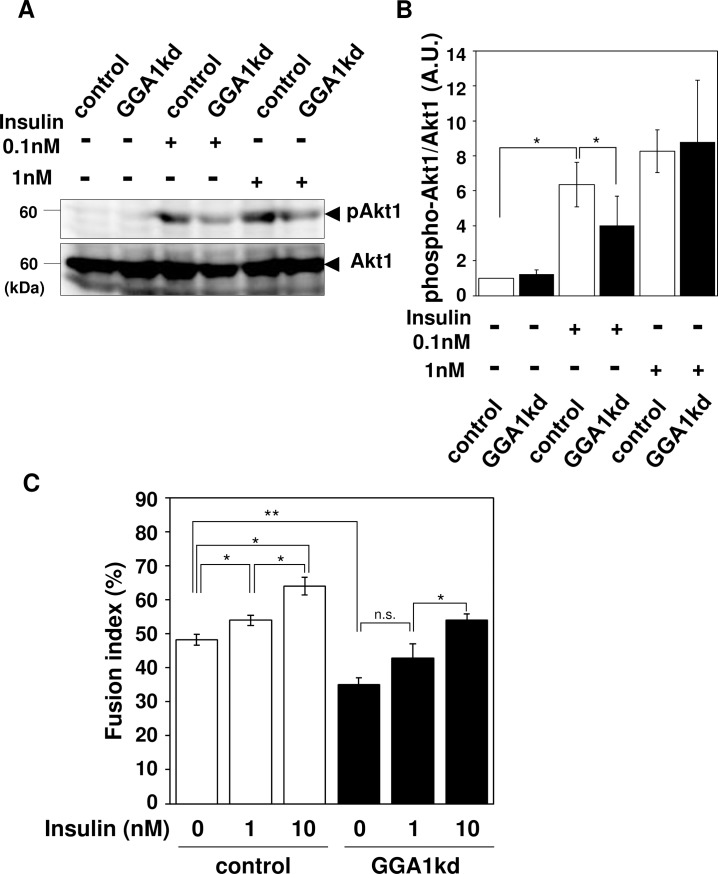
GGA1kd cells exhibit defective insulin response.(A) C2C12 cells treated with control and Gga1 (Golgi associated, gamma adaptin ear containing, ARF binding protein 1) siRNAs were stimulated by 0, 0.1, and 1 nM insulin for 5 min. Insulin signaling was then examined using anti-phospho AKT serine/threonine kinase 1 (AKT1) and anti-pan AKT1-specific antibodies. (B) The quantification of the phospho-AKT1/total AKT1 ratio is indicated on the right bar graph. (C) Wild-type and Gga1kd C2C12 cells were subjected to differentiation in the absence or presence of the indicated concentrations of insulin in the medium for four days. The formation of myotubes was then analyzed. Error bars indicate the SD (n = 3). *. P < 0.05, **. P < 0.01 by Welch’s t-test.